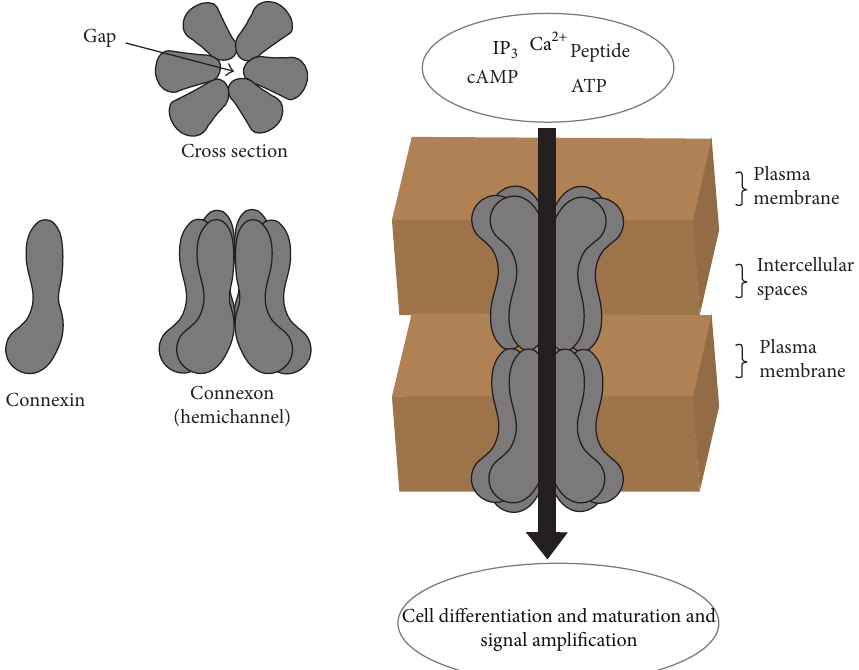
Figure 2: Six connexin molecules constitute a connexon hemichannel in the plasma membrane. Two hemichannels of adjacent cells docked together form a functional gap junction through which small molecules and peptides mediating cell proliferation and differentiation and maturation and amplification of intercellular signals can